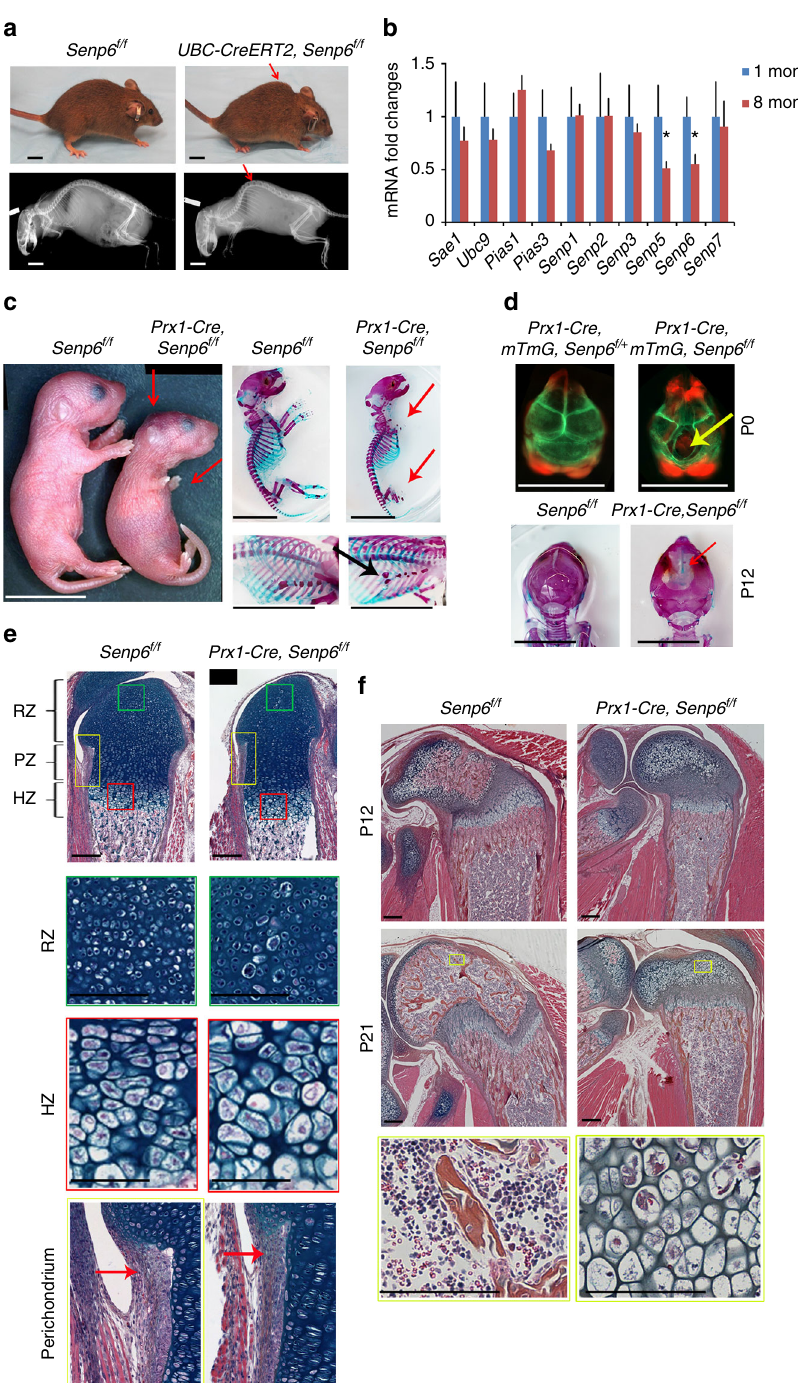
Fig. 1 Senp6 loss caused premature aging and skeletal developmental defects. a Four-momth-old UBC-CreERT2;Senp6 f/f mice developed kyphosis (red arrows) after tamoxifen-induced gene deletion (scale bars = 1 cm). b Expression of sumoylation system component genes in BMSCs derived from young (1 month) and older (8 months) mice ( n = 4, error bars = standard deviation, * p < 0.05, Student ’ s t -test). c P0 Prx1-Cre;Senp6 f/f mice show smaller limbs (red arrows), asymmetric patterning, and decreased ossi fi cation of the sternum (black arrow). Scale bars = 1 cm. d Undermineralized cranial bone in P0 Prx1-Cre;Senp6 f/f ;mTmG mice (upper panel). The green fl uorescence indicates the region with active Cre expression; the yellow arrow denotes the opening of the skull. In P12 Prx1-Cre;Senp6 f/f mice (lower panel), the red arrow indicates the Alizarin red – negative region of the skull. Scale bar = 1 cm. e A distal femur of a P0 Prx1-Cre;Senp6 f/f mouse shows a reduced growth plate diameter and enlarged chondrocytes in the resting zone (RZ) and hypertrophic zone (HZ), as well as a thinner perichondrium (red arrows). The colored boxes are enlarged and shown in the lower panels; scale bars = 100 μ m for the growth plate and 50 μ m for the rest. f Prx1-Cre;Senp6 f/f mice showed dramatically delayed formation of the secondary ossi fi cation center (SOC) at P12 and P21. The yellow boxes are enlarged and shown in the lower panels. Scale bars = 100 μ m for the growth plate and 50 μ m for enlarged yellow